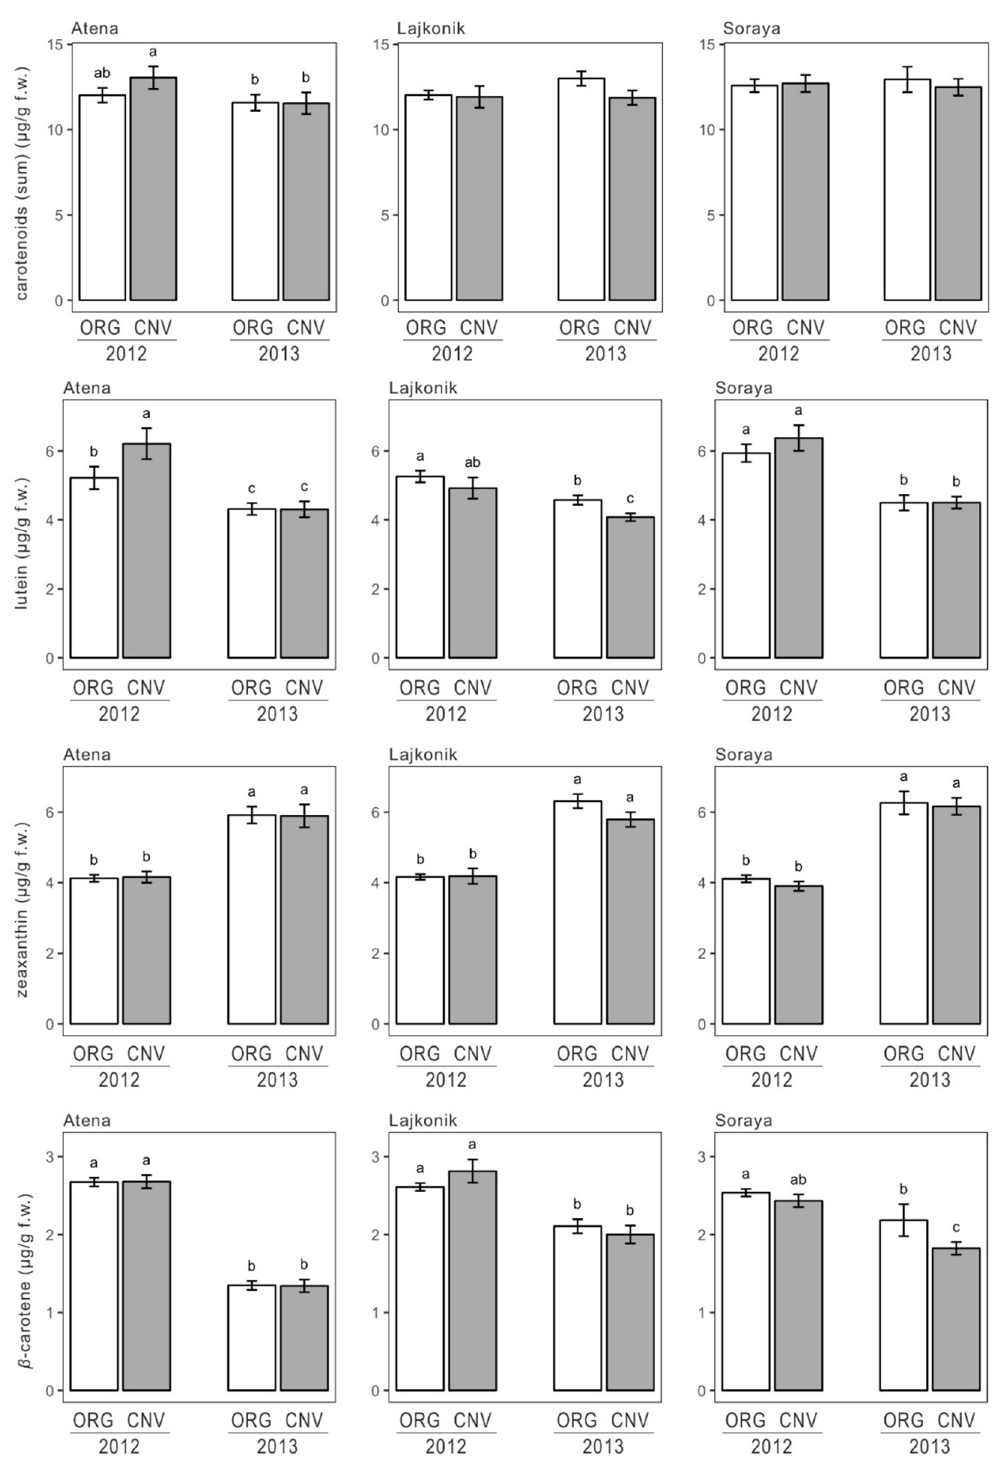
Figure 7. Carotenoids (sum), lutein, zeaxanthin and β -carotene content in organic (ORG) and conventional (CNV) courgette fruits of Atena, Lajkonik and Soraya cultivars grown in two consecutive years. Data are presented as means with standard errors. Within each cultivar, bars marked with the same letters are not significantly different at the 5% level of probability.